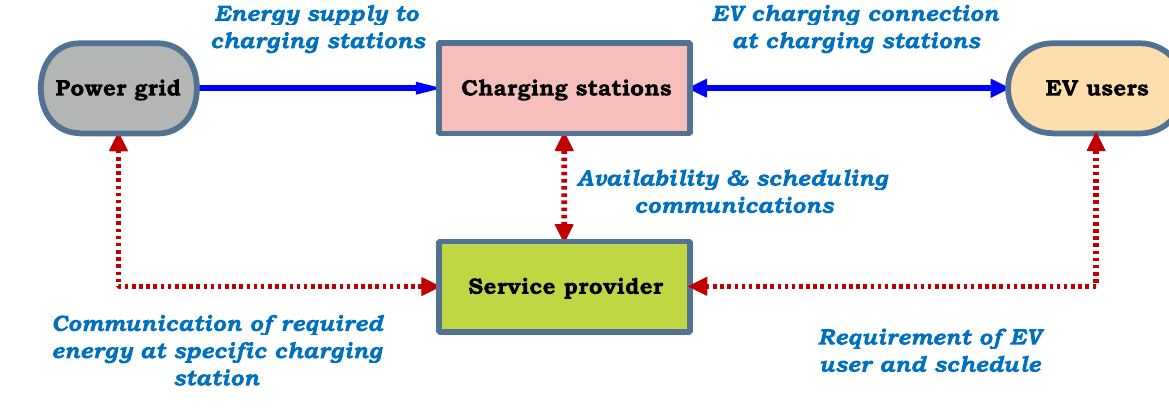
Figure 4. Energy flow and communication in EVCS.